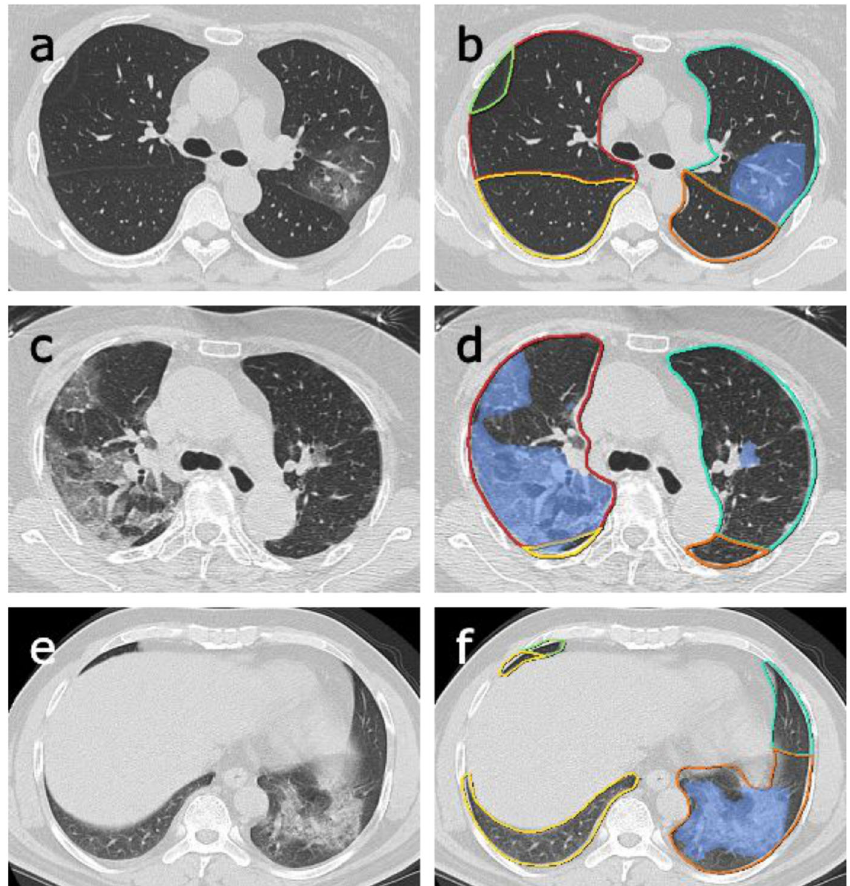
Fig. 5 Examples of lesion segmentation by the AI system. Left a , c , e : original images; right b , d , f : pulmonary lobes (colored lines) and opacities segmentation (blue